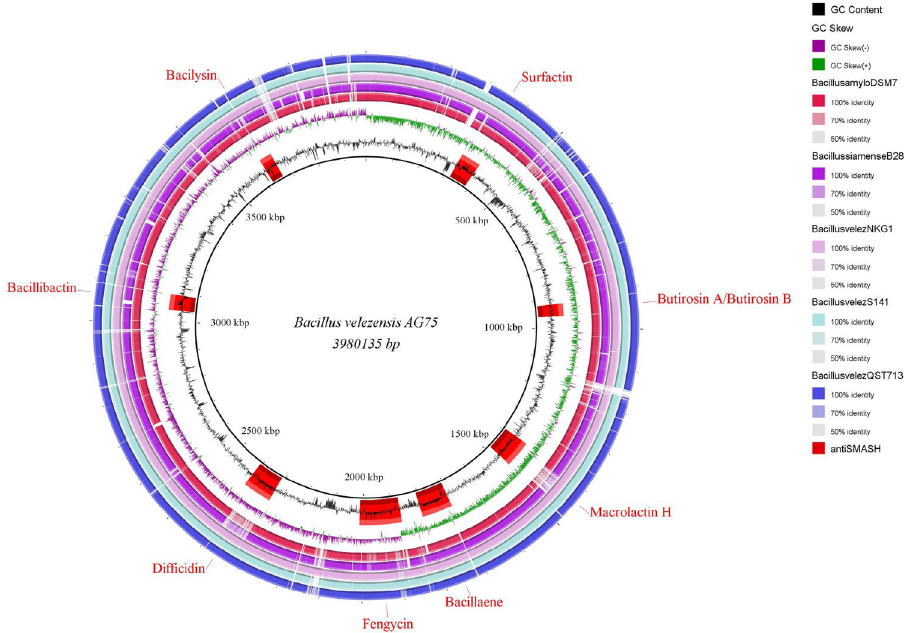
Figure 5. Circular representation of the genome of Bacillus velezensis strain Ag75 using the BRIG program. From inside to outside, the legends are as follows: GC content, GC slope, and position of BGCs in the genome indicated by antiSMASH for DSM7, B28, NKG-1, S141, and QST